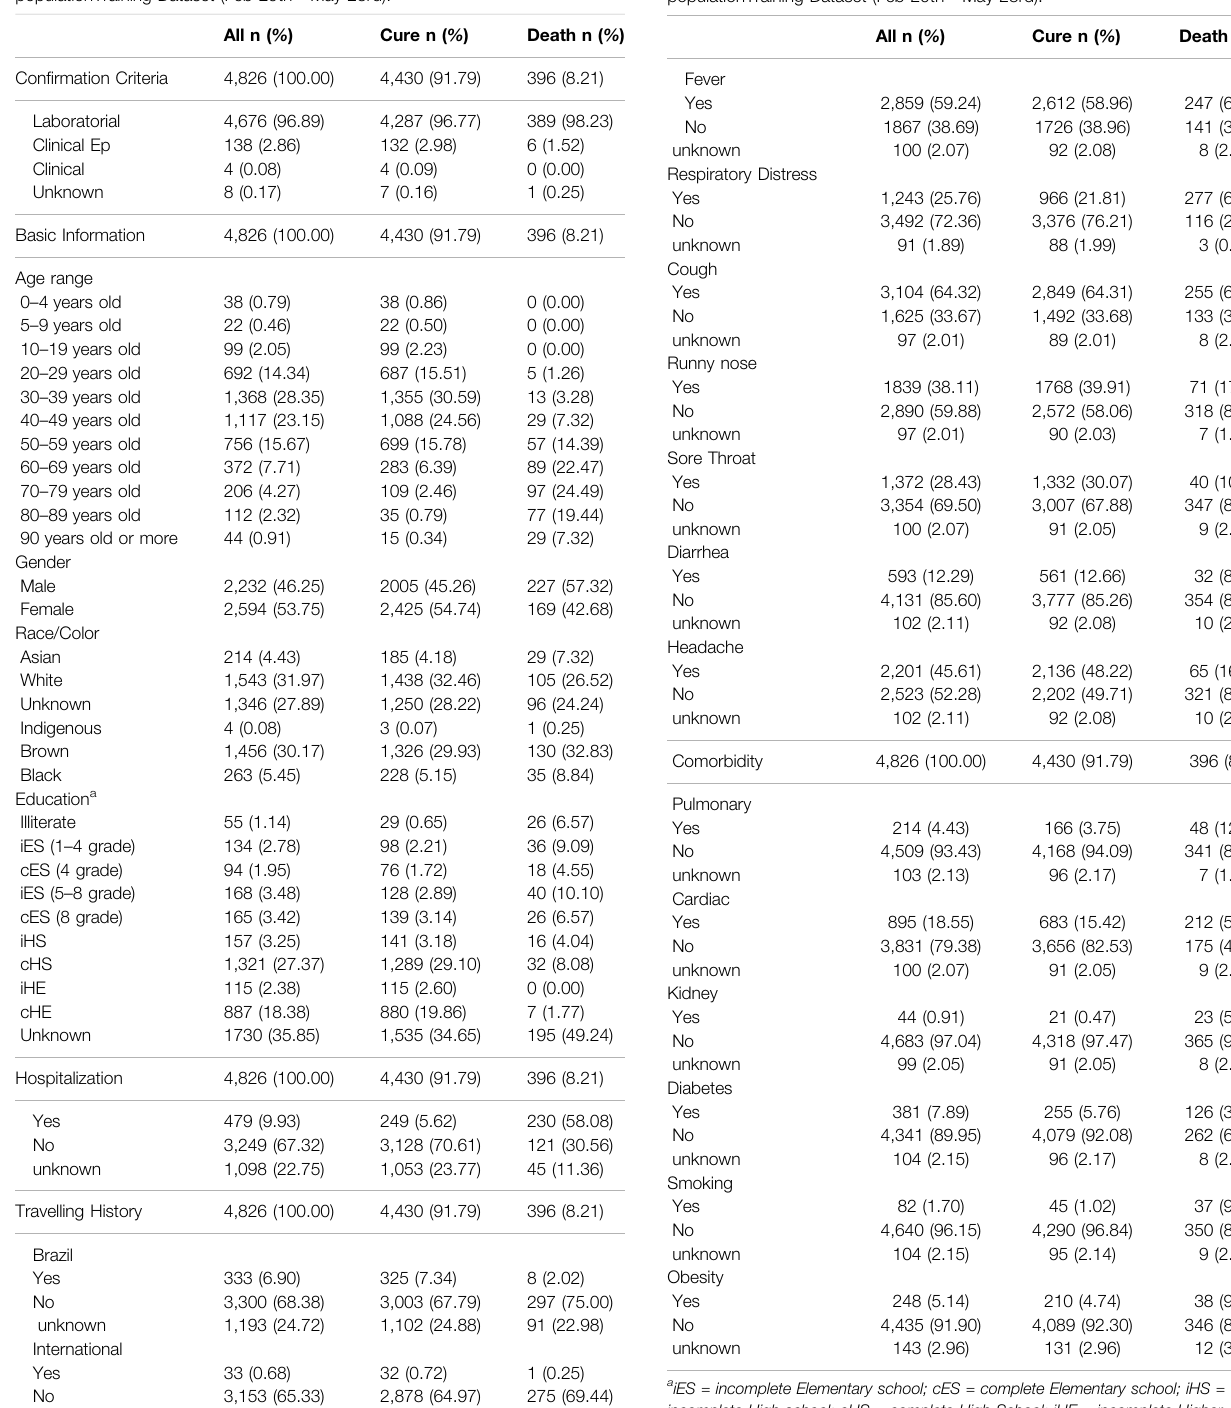
TABLE 1 | ( Continued ) Demographic data and clinical characteristics of the study populationTraining Dataset (Feb 29th - May